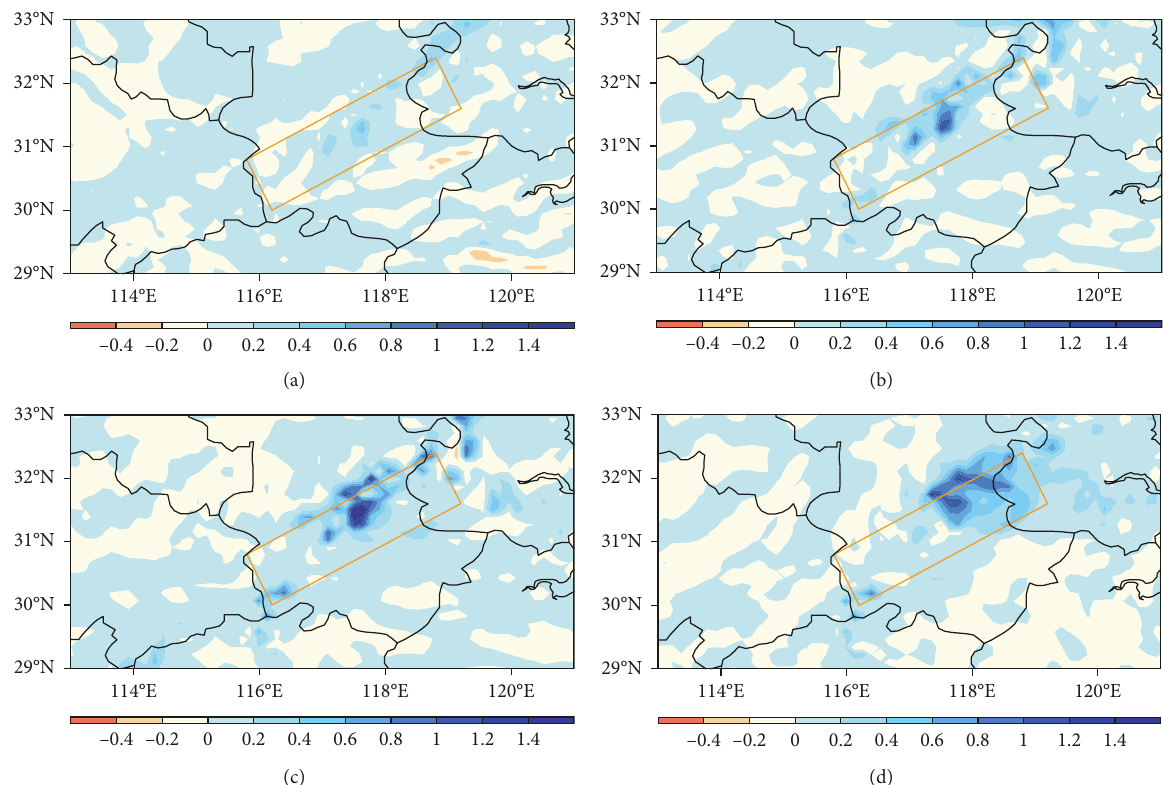
1 ) at various heights (a) 1km, (b) 3km, (c) 5km, s · −